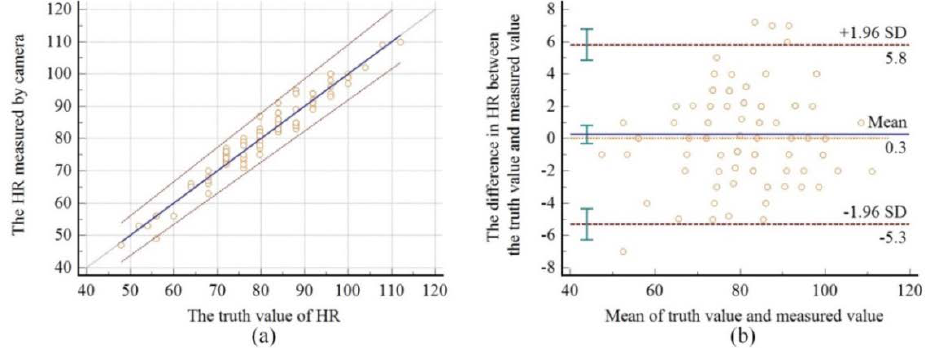
Figure 6. Bland-Altman diagram. ( a ) The regression line between the true heart rate and the measured value of camera: the abscissa represents the true heart rate, and the ordinate represents the value measured by the camera; ( b ) the level of consistency between the true heart rate and the value measured by the camera: the abscissa represents the average difference between the true heart rate and the value measured by the camera, and the ordinate represents the difference between the true heart rate and the value measured by camera.